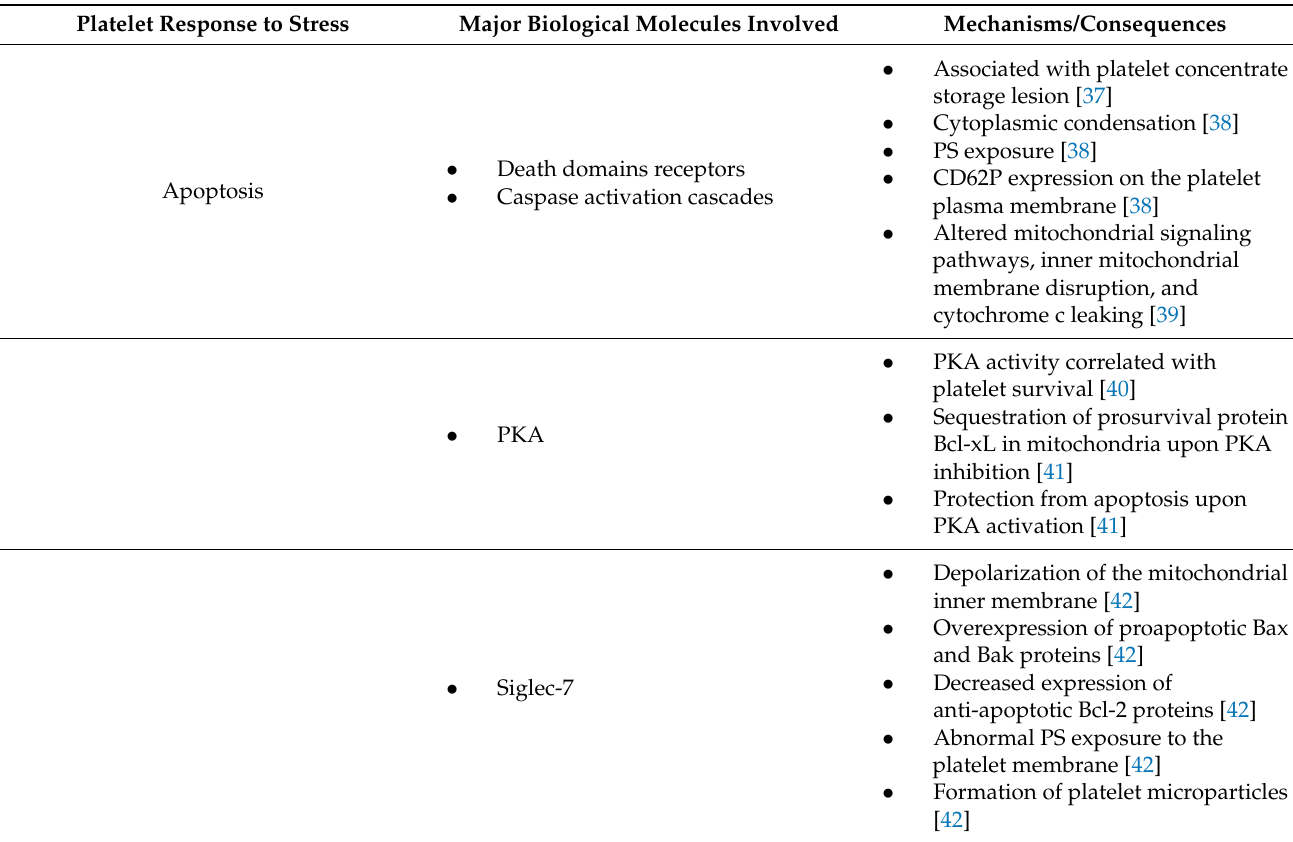
Table 1. Platelet response to